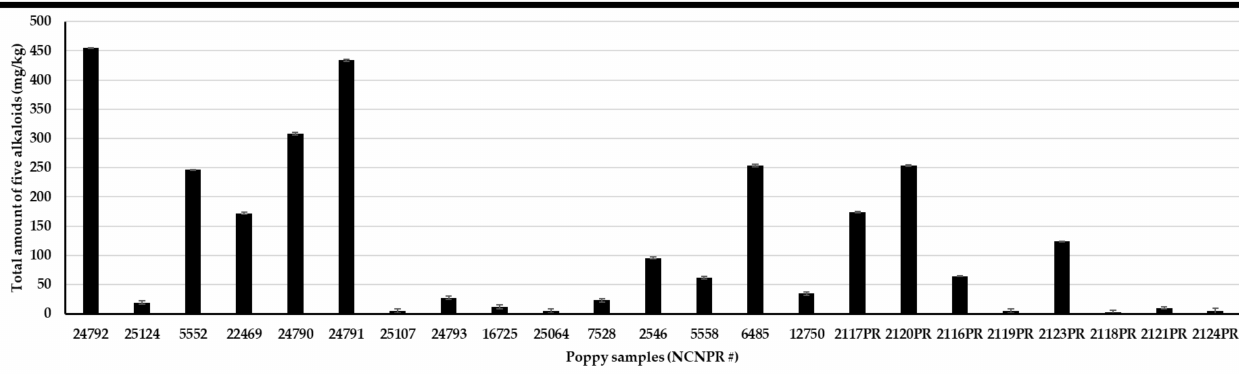
Figure 6. Total five OAs content (mg/kg) of different poppy seed